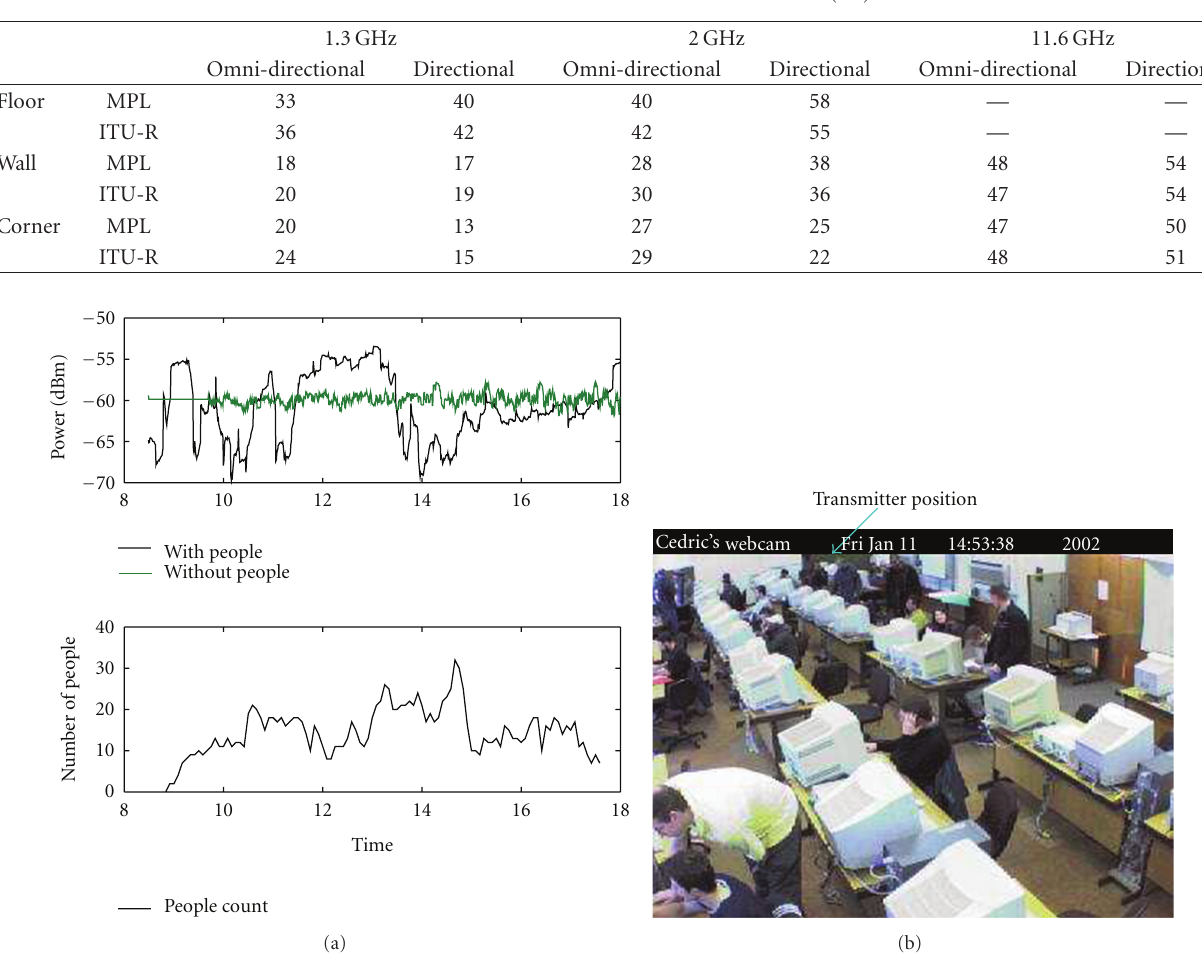
Figure 5: (a) Correlation between the number of people in the room and signal level at 2 GHz and (b) an image of the indoor environment showing the view from the receiver